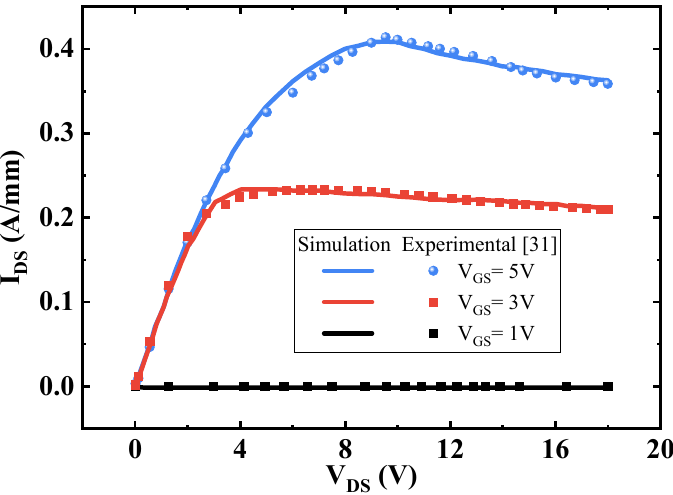
Figure 2. Experimental [31] and numerical simulation on-state characteristic curves at V GS = 1, 3, 5 V. Table 1. Parameters of Con, Dc, and Proposed BP-HEMT.